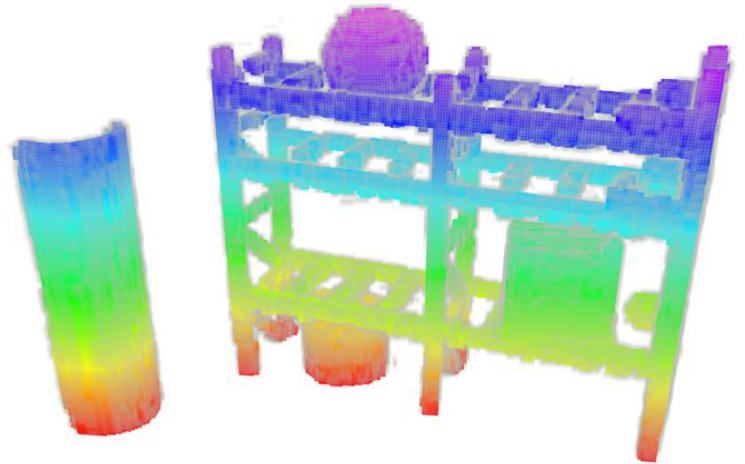
Figure 4. FIIMap representation of in-progress exploration in a gazebo simulator (https://gazebosim.org/home). (accessed on 18 January 2022). The colored voxels are occupied. The dark white voxels are inflated spaces that are virtually occupied.